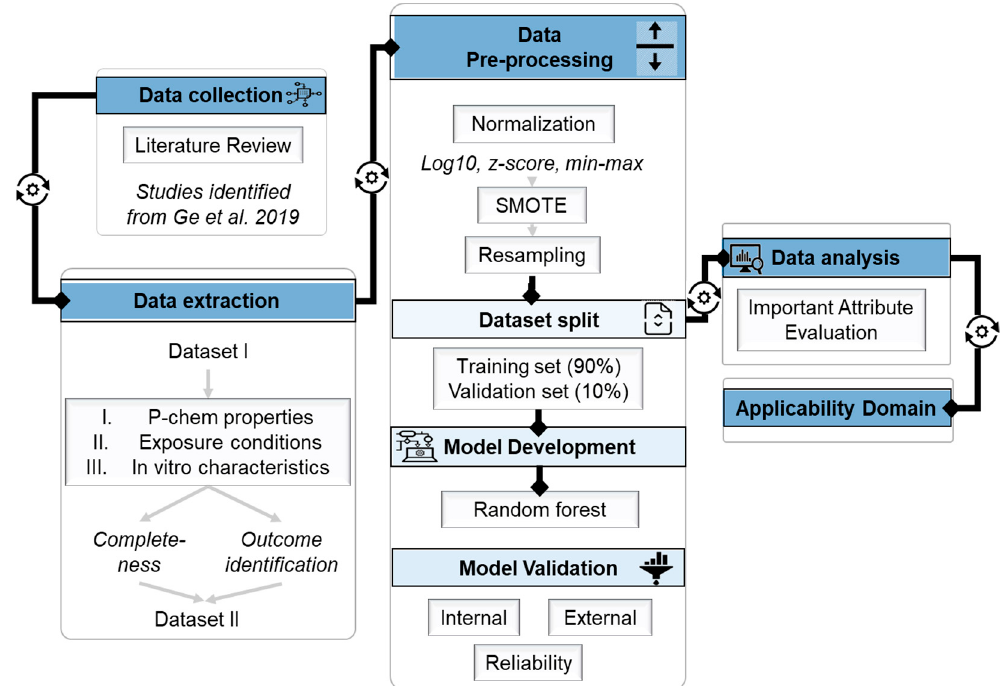
Figure 1. Model development workflow.